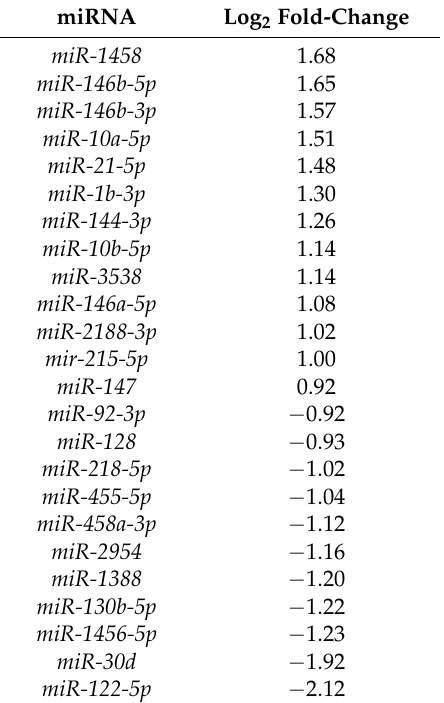
Table 1. Cellular micro RNAs (miRNAs) differentially expressed (minimum CPM cutoff of 20; log 2 fold change cutoff of 0.9; and FDR < 0.05) between mock-infected and Marek’s Disease Virus (MDV)-infected spleens at 42 dpi identified by small RNA-sequencing. miRNA Log 2 Fold-Change miR-1458 1.68